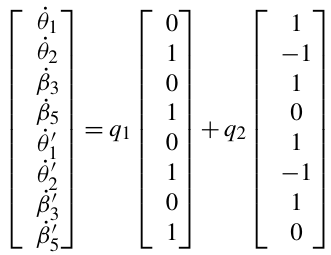
3 Kinematic analysis of novel 2-DOF translational